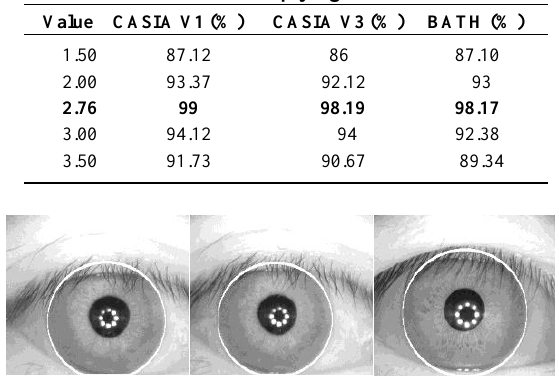
Figure 4. Iris outer boundary localized for three eye images.